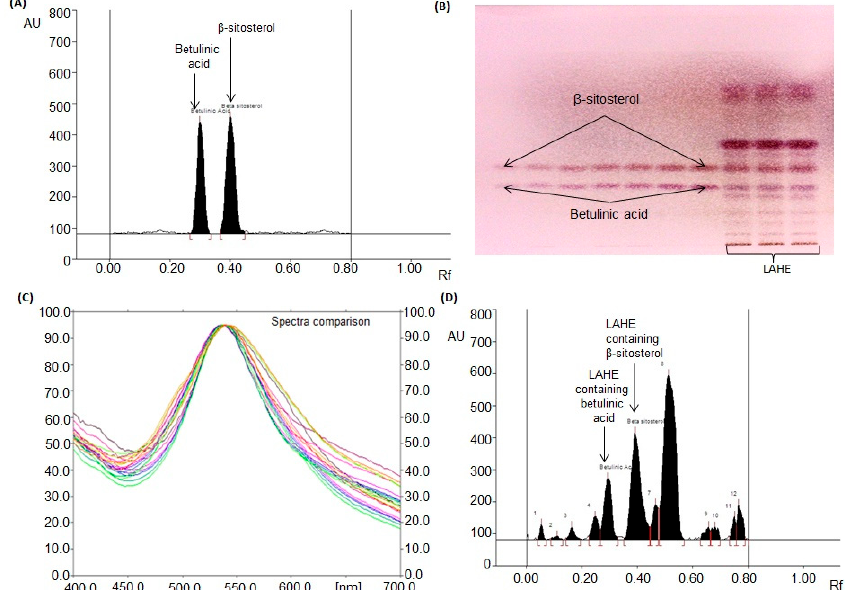
Figure 4. Chromatogram of betulinic acid and β -sitosterol estimation in L. acacia hexane extract